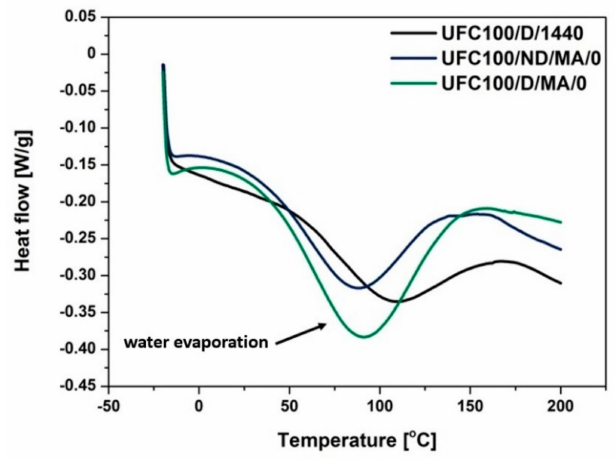
Figure 10. Comparison of cellulose fibers MA treatment e ff ect on the water evaporation phenomenon according to the di ff erential scanning calorimetry (DSC) curves.